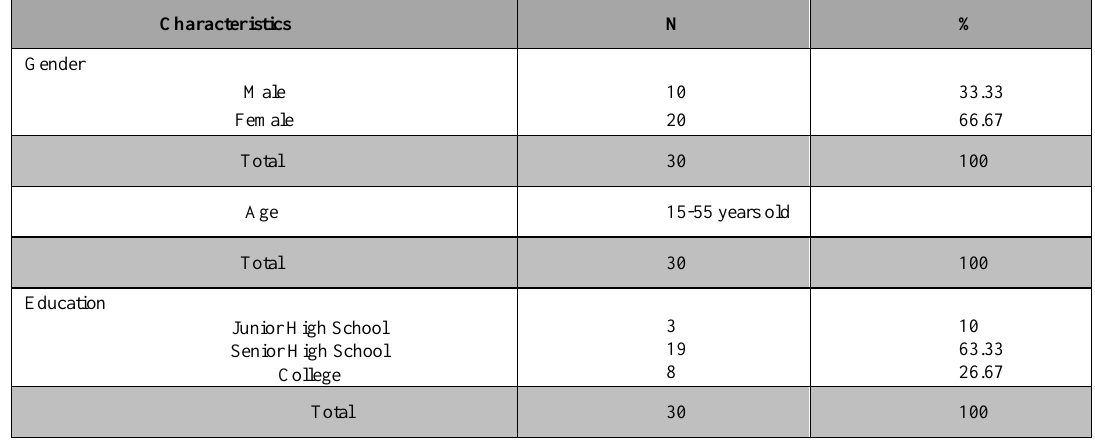
Table 1. Study samples characteristics.